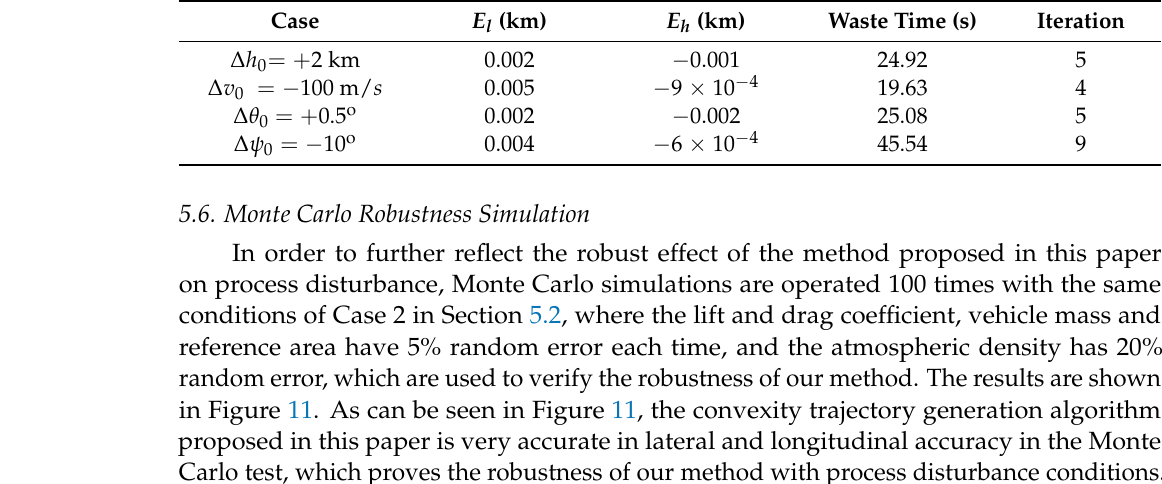
Figure 10. The generation effects of the initial state with disturbance: ( a ) represents the lateral trajectories; ( b ) represents the longitudinal trajectories; ( c ) represents the control angles.